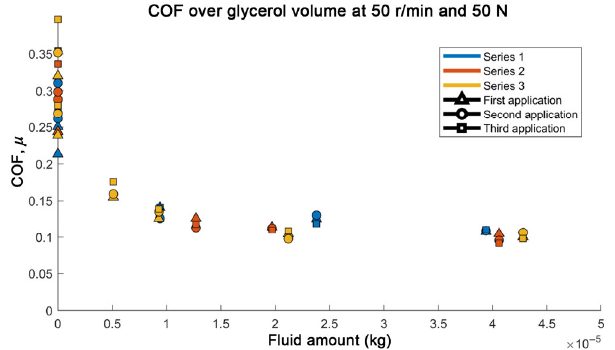
Fig. 11 COF vs. amount of fluid for the system with the finely 0 5 10 kg.     filed pin, zoomed in range of 5 glycerol,fine